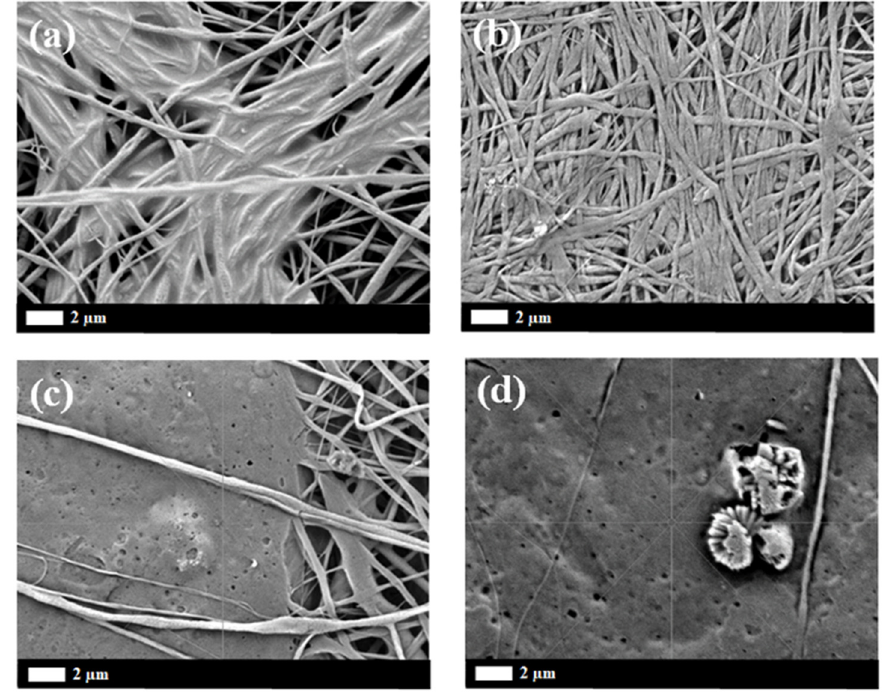
Figure 12. SEM micrograph of the PLLA/CMS/ β -TCP morphology after 60 days immersion at different irradiation doses: ( a ) non-irradiated; ( b ) 5 kGy; ( c ) 30 kGy; and ( d ) 100 kGy.